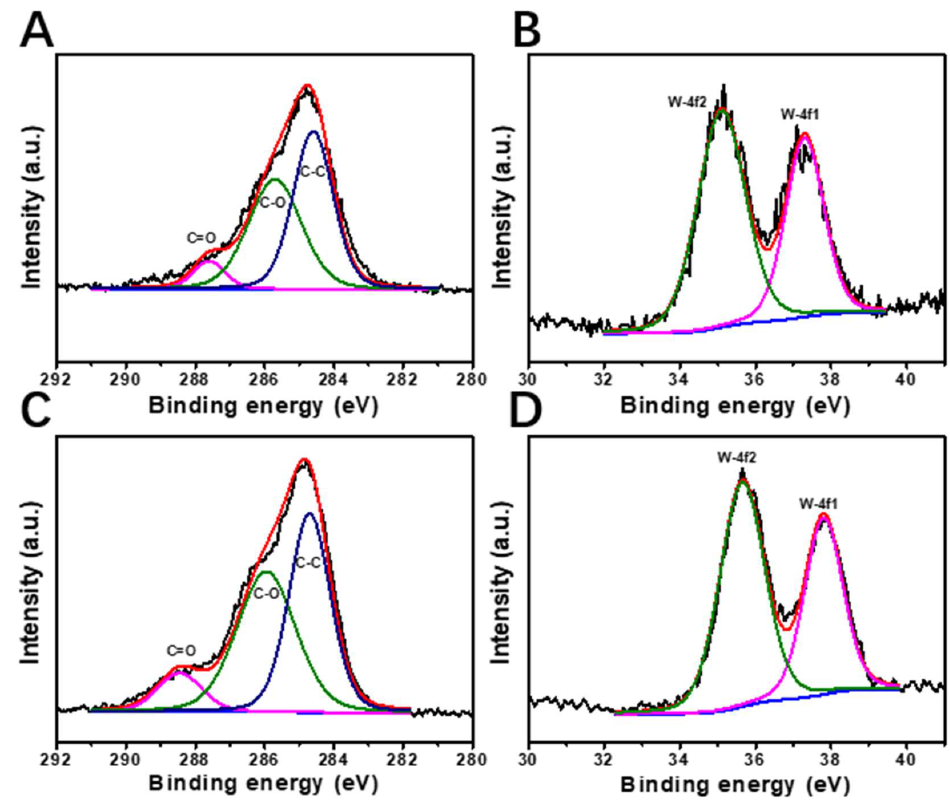
Figure 5. C1s spectra of A-CNF/PTA50% before ( A ) and after ( C ) catalysis. W4f spectra of A- CNF/PTA50% before ( B ) and after ( D ) catalysis.